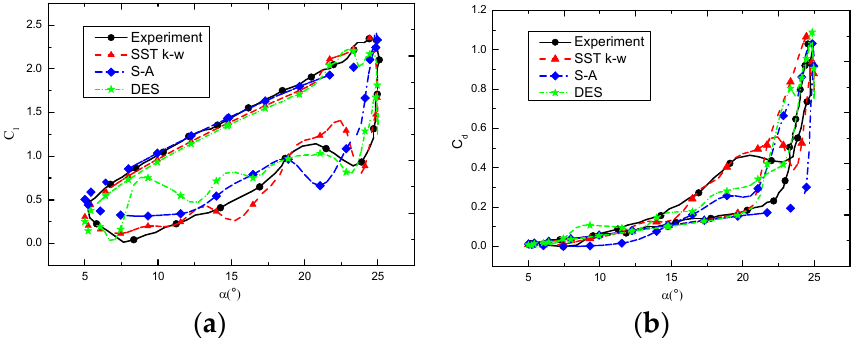
Figure 3. Turbulence model validation. ( a ) Lift coefficient, ( b ) Drag coefficient.